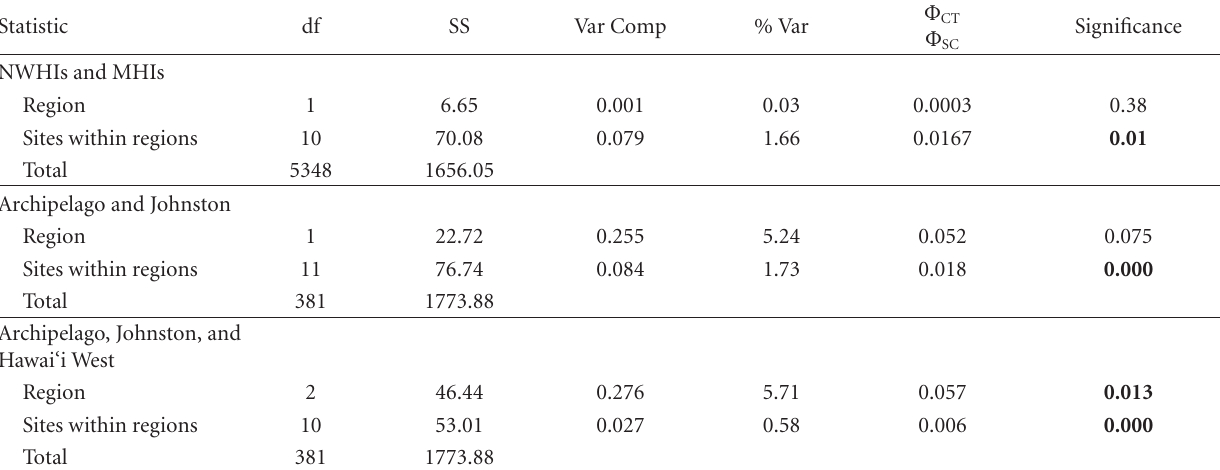
Table 2: Analysis of molecular variance results for Acanthaster planci populations along the Hawaiian Archipelago and from Johnston Atoll. The regional variance component relative to the total variance is Φ CT . The between-site within region variance component divided by the sum of itself and the within-site variance is Φ SC . Statistical significance ( P < . 05) is indicated by the bold